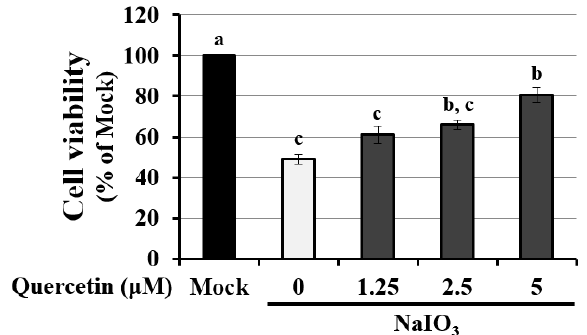
Figure 3. Activities of oxidative metabolic enzymes. All enzymes were measured 7 days after NaIO 3 treatment in the mock, NaIO 3 , and NaIO 3 + quercetin groups of mice. SOD, catalase, and glutathione were measured using commercial assay kits. Data are demonstrated as mean ± SD ( n = 8, 8 individual set experiments per set of groups). The letters a, b, and c indicate statistically significant difference ( p < 0.05).